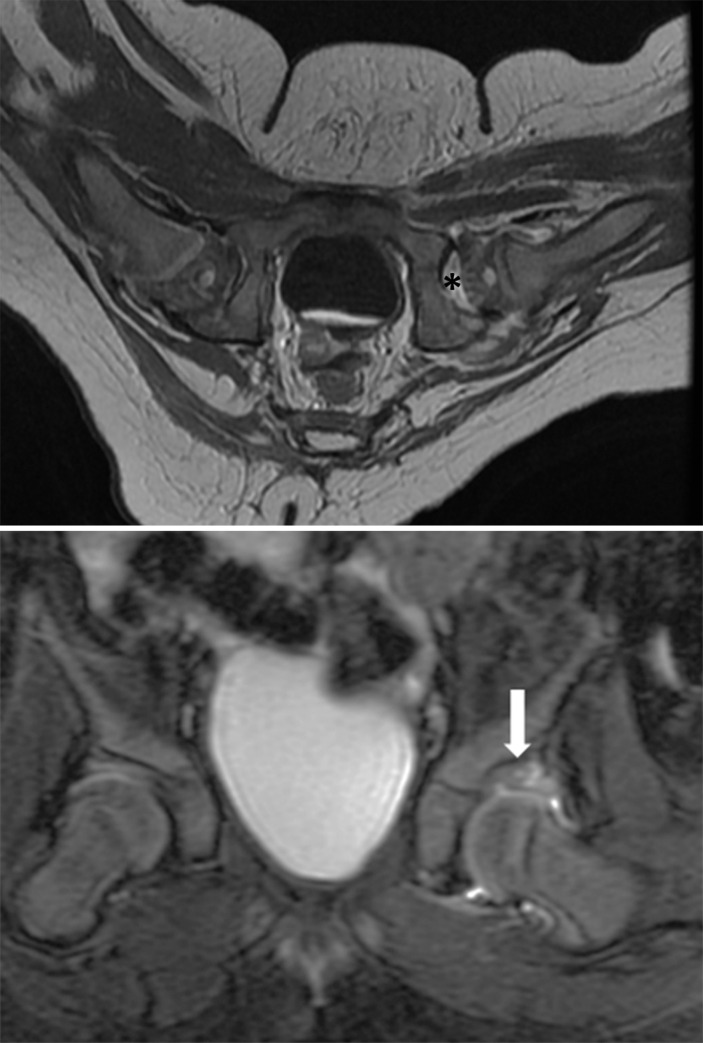
Obstacles of closed reduction: MR features.A. The contrast-enhanced axial T1-weighted image shows the pulvinar (asterix) as a thick fibrofatty tissue blocking concentric reduction in the left hip joint space. Note the punctate enhancement of the left proximal femoral epiphysis. B. Coronal T2-weighted with fat-suppression obtained after closed reduction of the left hip shows triangular shaped, hyperintense soft tissue at the chondrolabral junction of the left acetabulum (arrow) reflecting the neolimbus.